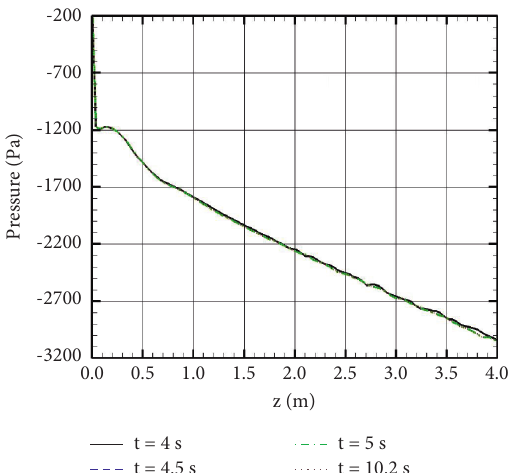
Figure 2: Pressure variation along the pipe axis for different time instants and for the 3D-T configuration.